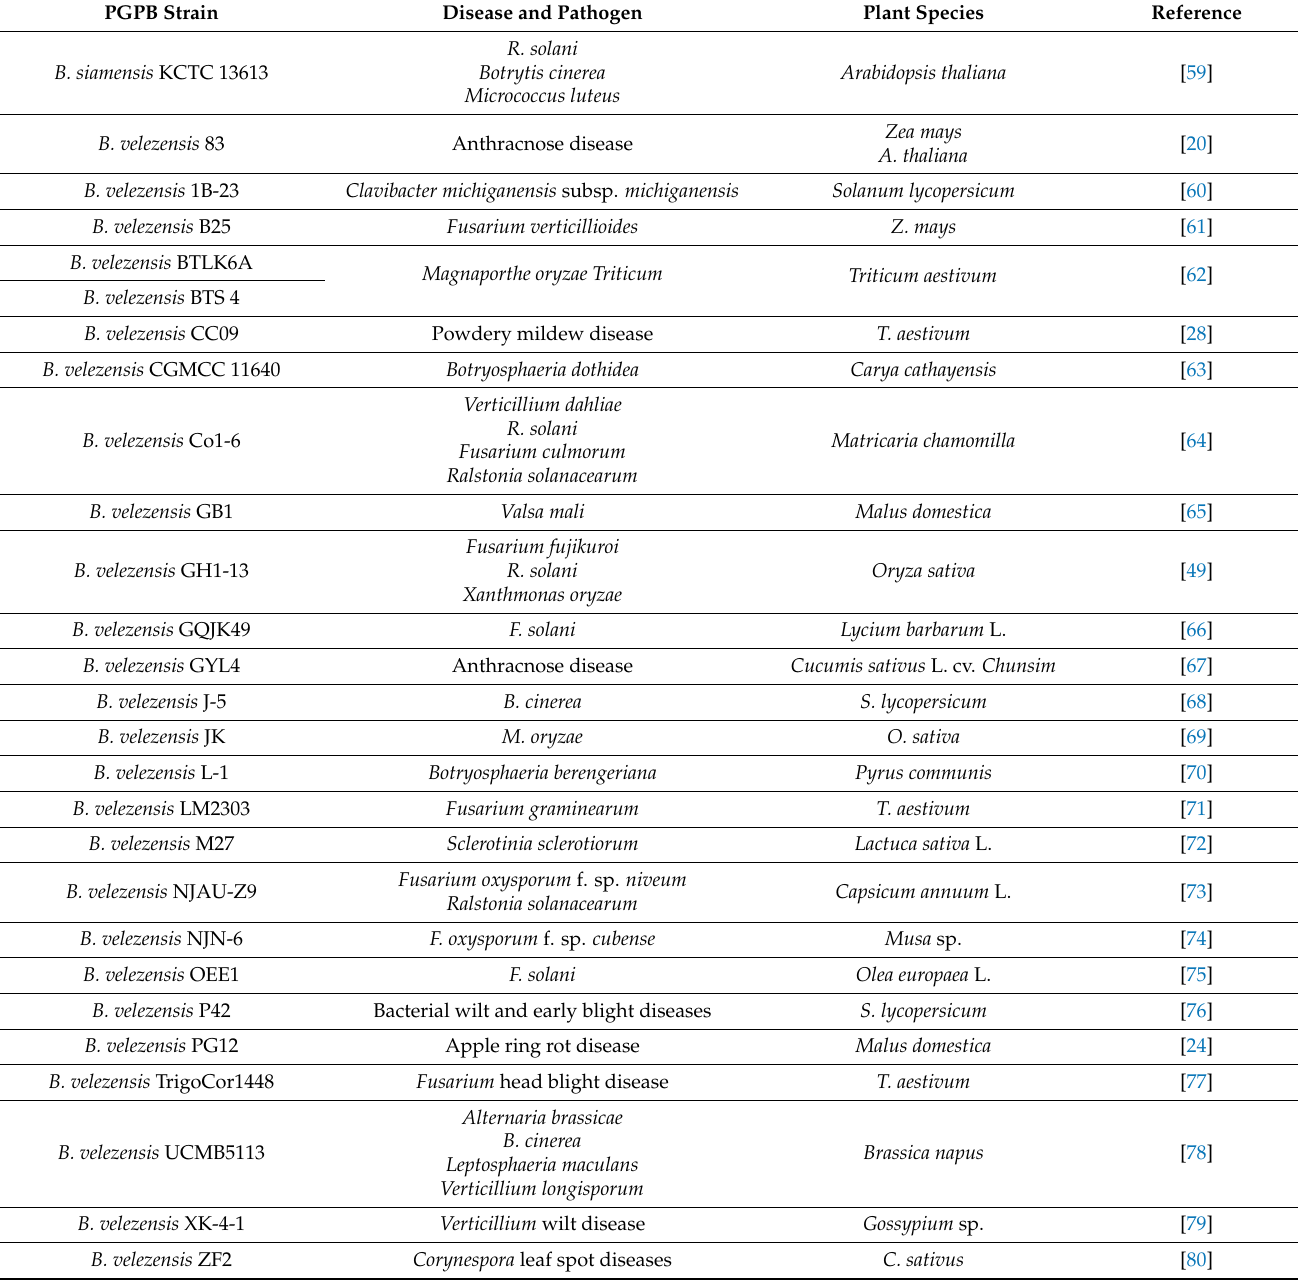
Table 2. Plant pathogen suppression by members of the operational group Bacillus amyloliquefaciens in various plant species. PGPB Strain Disease and Pathogen Plant Species